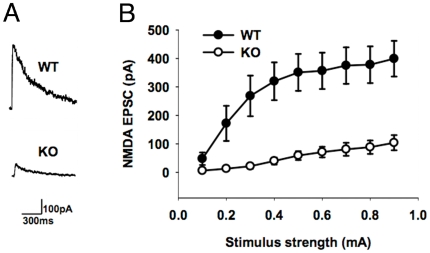
Absence of evoked NMDA receptor currents in hippocampus during early development of EphA5 functional knockout mice.(A) Examples of NMDA EPSCs evoked in the CA1 pyramidal neurons in hippocampal slices from postnatal day 6 EphA5-functional knockout and matched wild-type mice. (B) Average amplitude of NMDA EPSCs in EphA5-functional knockout (15 slices from 5 mice) and matched wild-type mice (15 slices from 5 mice). EphA5-functional knockout mice show significantly lower NMDA EPSC amplitude compared to the matched wild-type mice. P<0.001, two-way ANOVA.